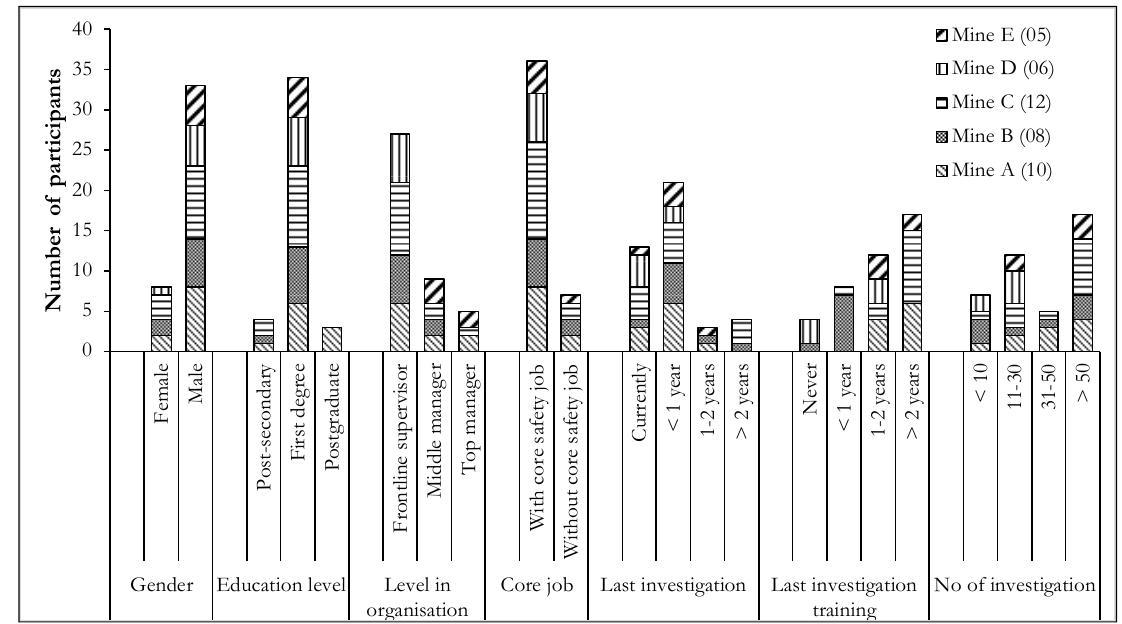
Figure 1. Comparison across mines of the characteristics of the interview participants.